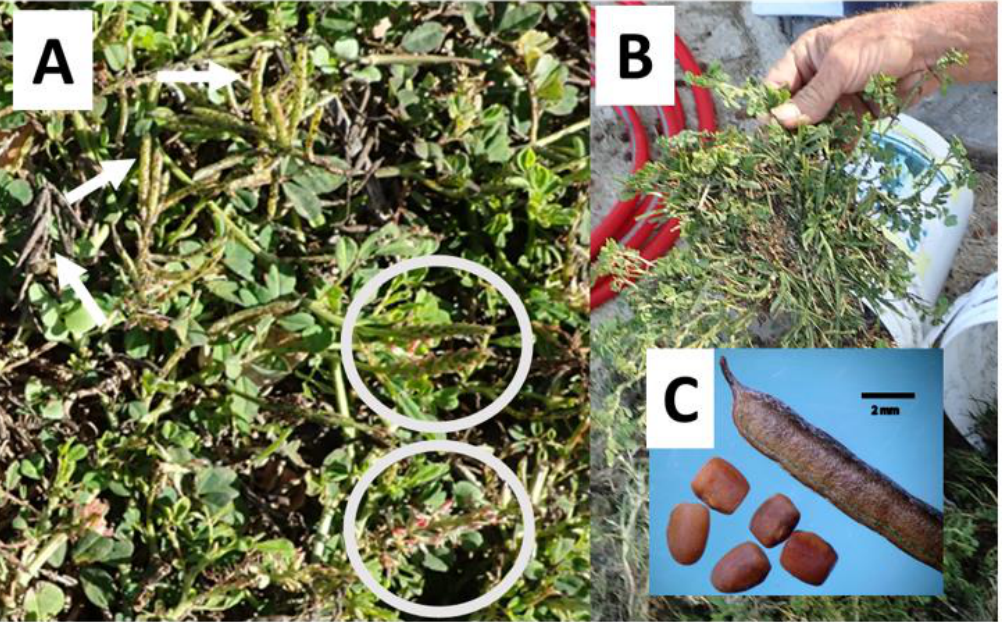
Figure 2. Creeping indigo on Oahu island, Waialua Polo Ranch: ( A ) the white circles enclose pink inflorescences arranged in elongated clusters (≈10 cm long) with oblong dark green leaves typical of Fabaceae, with 5 – 11 leaflets per stem arranged in an alternating pattern (0.5 – 2.5 cm long). The white arrows point to clusters of bright green immature and dry narrow straight cylindrical pods (≈2.5 cm long); ( B ) uprooted creeping plant; ( C ) typical hairy stiff dry pod with pointed hooked tip, contains 4 –8 light brown quadrangular ≤2 mm -long seeds (bar = 2 mm).